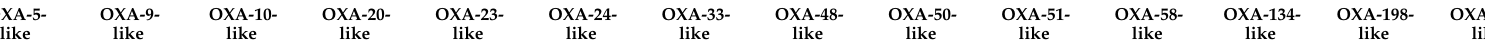
Table 4. Root Mean Square Deviation values of pairwise structure alignments of 3D protein models of the 16 OXA